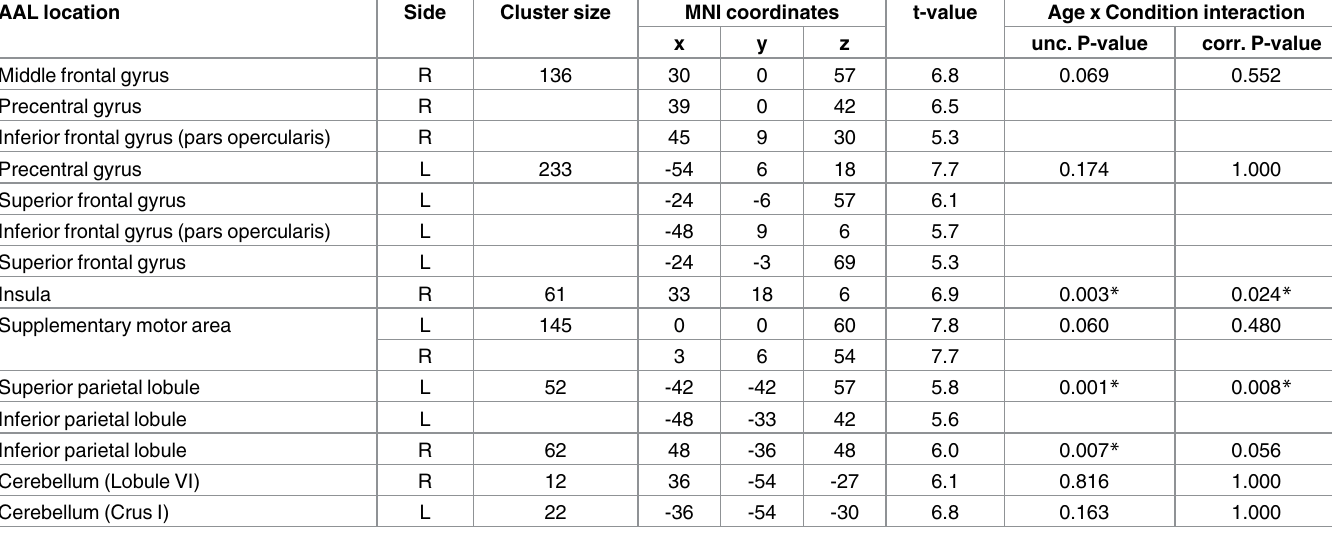
* denotes significant interaction with p < 0.05.